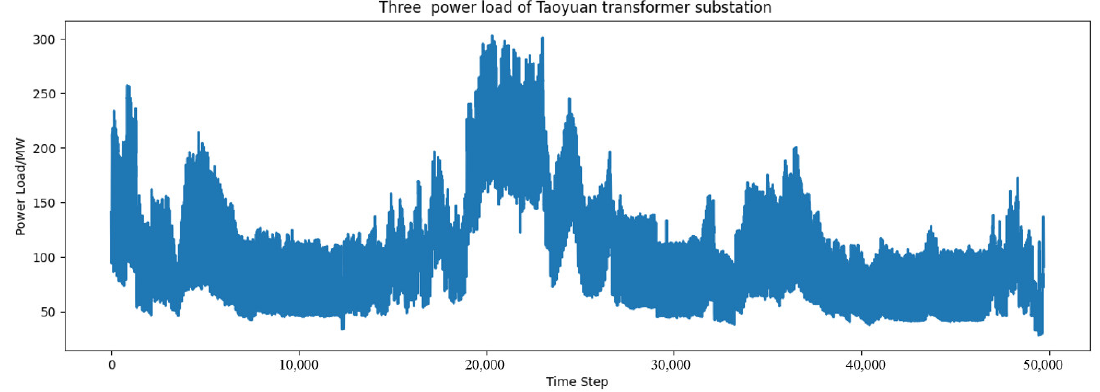
Figure 6. Data overview of Nanchang Taoyuan substation.